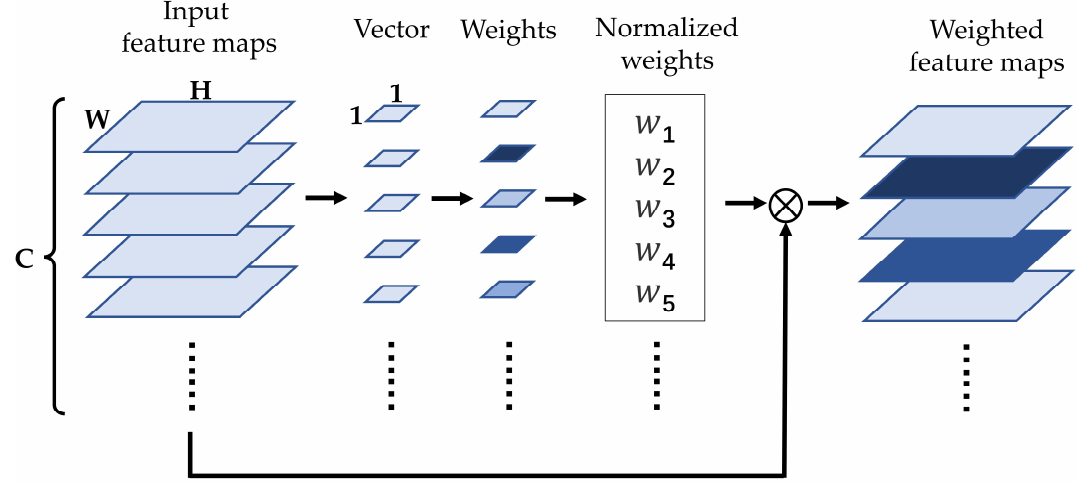
Figure 5. Channel-excitation feature encoder. ⊗ indicates element-wise